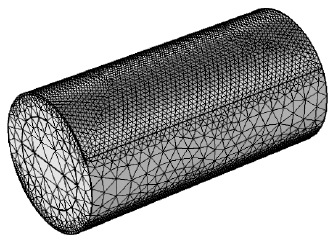
Figure 3. Meshed models of the CCS with water holdup of 50%.